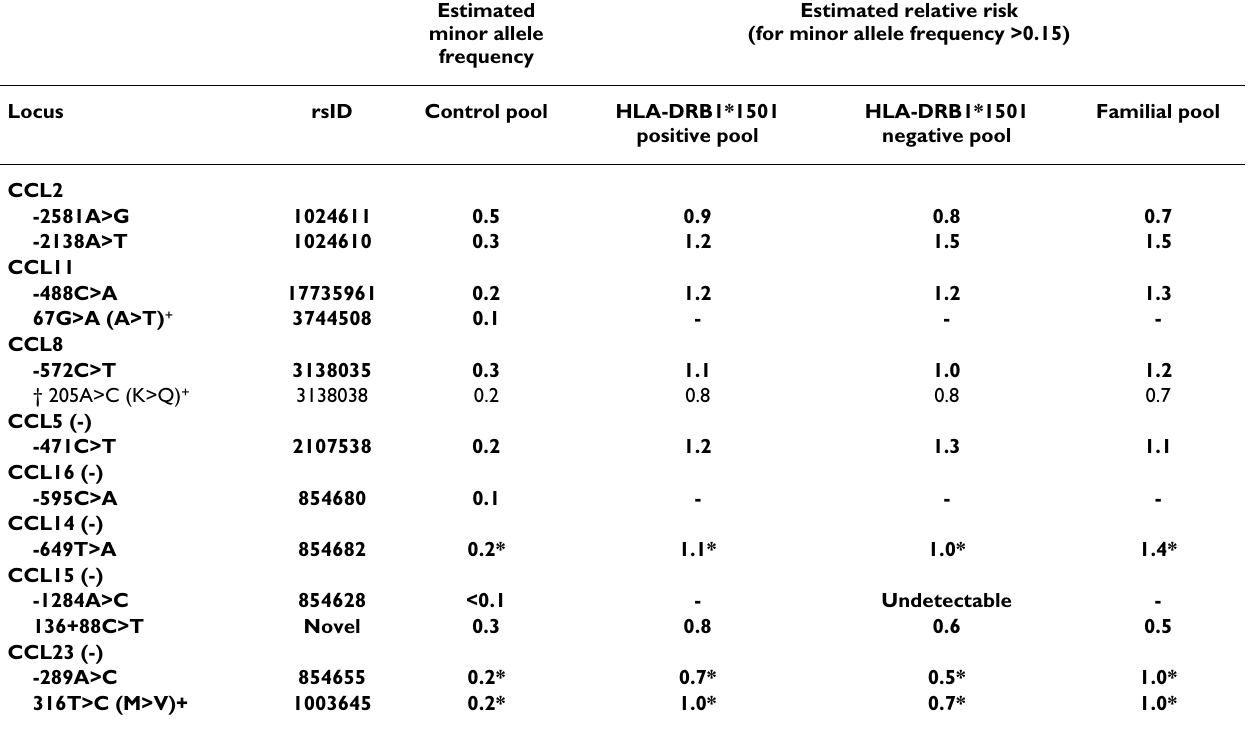
Table 1: Summary of SNPs identified by sequencing of CC chemokine genes in DNA pools that were selected for individual genotyping. Other detected SNPs are described in Supplementary Table 2. Estimated minor